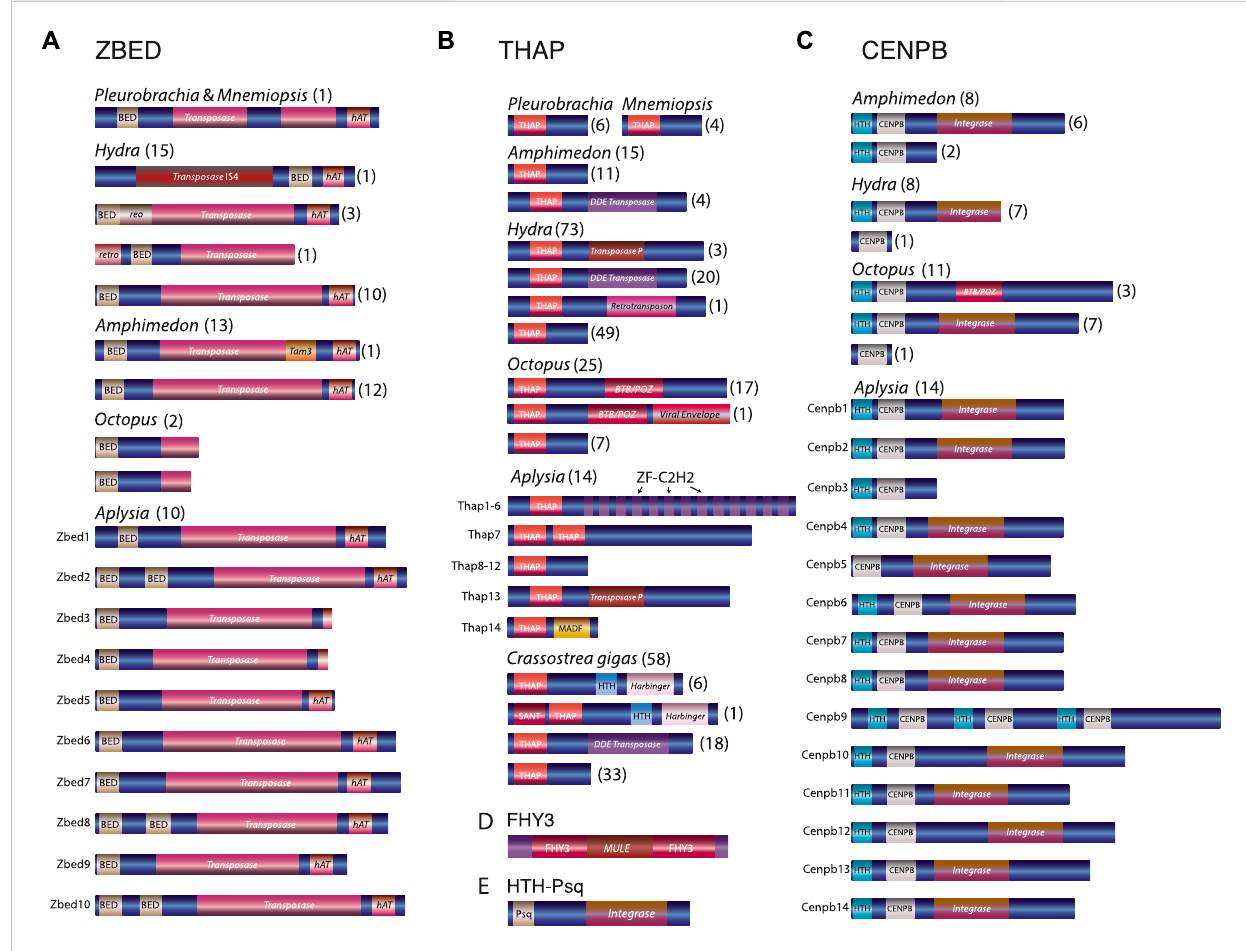
FIGURE 3 Domainorganizationsofthetransposon-derivedtranscriptionfactorsacrossmetazoans (A – E) .Transposoninsertionsdomainsareshowninshaded red color and labeled as integrase , transposase , Harbinger , BTB/POZ, etc., Note that the same transcription factor protein families have different transposoncomponents.Forexample, Octopus CENPBandTHAPproteinshavederivedmostlyfromBTB/PoxvirusBTB(Godtetal.,1993)/POZ(Bardwell and Treisman, 1994)transposable elements, whereas, inother species, the sameTFs have originated from multiple differenttransposableelements. Similarly, Hydra ZBEDgenescouldhavederivedfromatleastthreetransposonsourcessuchas retrotransposon , reoviruses, and transposonIS4, whereas all Aplysia ZBED genes seem to have derived from Ac transposon (Supplementary Figures S5, S6). Numbers within parentheses indicate the number of genes identi fi ed with a similar domain